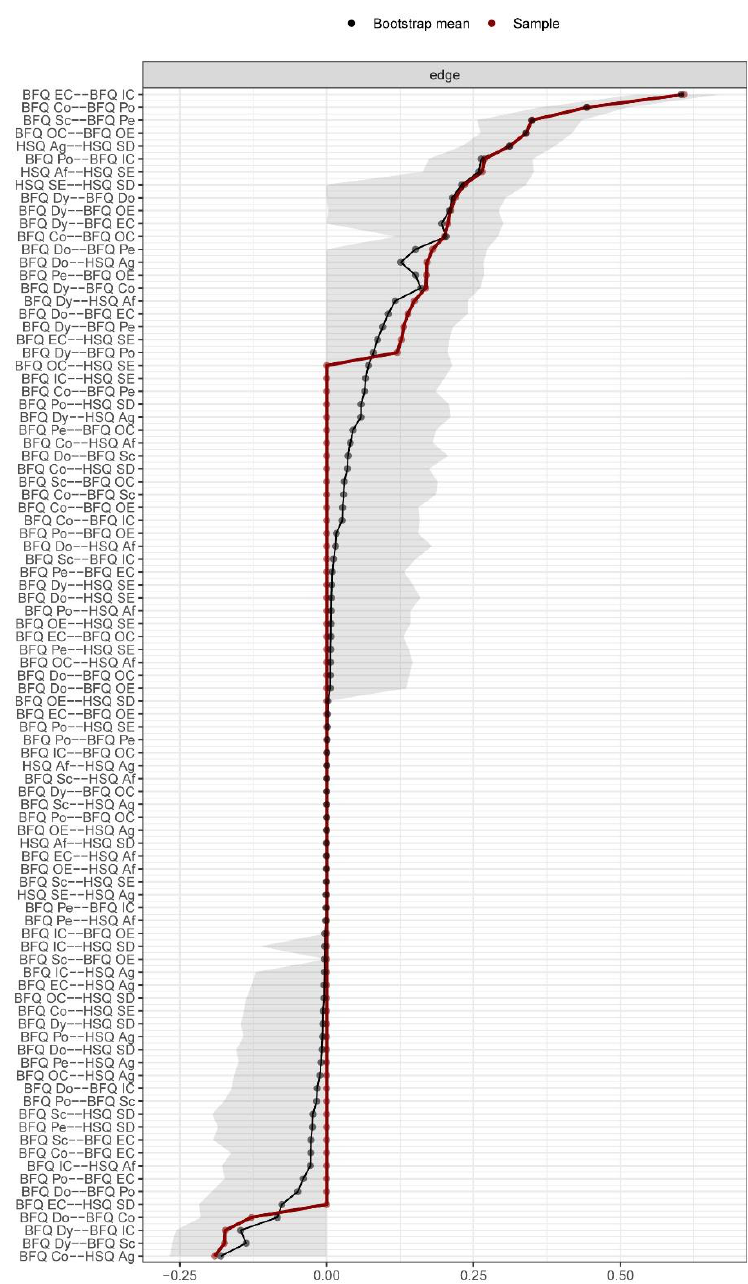
Figure 6. Network of Humor Styles dimensions and Big Five Personality facets: Bootstrap tests of the edge weight accuracy [95% confidence intervals] ( n = 462). Note: Big Five Questionnaire (BFQ) ten facets. Dy: Dynamism; Do: Dominance; Co: Cooperativeness; Po: Politeness; Sc: Scrupulousness; Pe: Perseverance; EC: Emotion Control; IC: Impulse Control; OC: Openness to Culture; OE: Openness to Experiences. Humor Style Questionnaire (HSQ) four dimensions. Af: Affiliative; SE: Self-enhancing; Ag: Aggressive; SD: Self-defeating.